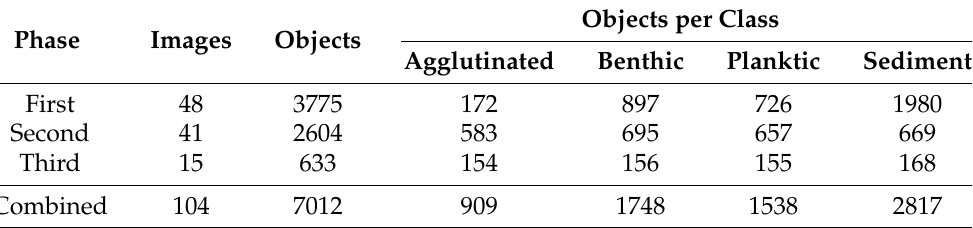
Table 1. Detailed breakdown of the object dataset, where each row holds information for a specific microscope image acquisition phase. The first and second phases contain only “pure” images where every object is of a single class, whereas the third phase images contain only mixtures of several classes.